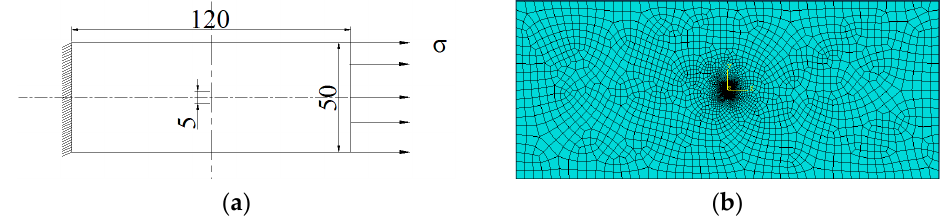
Figure 8. ( a ) The 90° central symmetric crack mode, and ( b ) 90° central symmetric crack developed with numerical model.